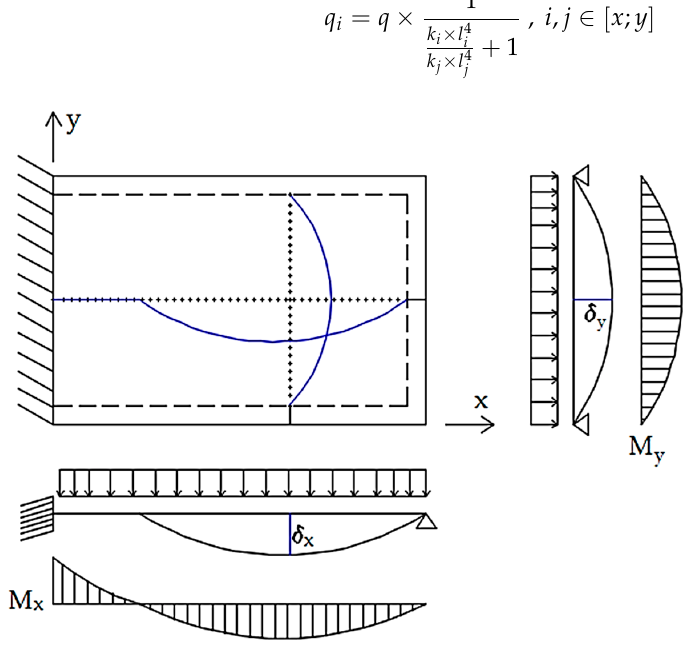
Figure 9. Displacement compatibility at one point for a slab with one fixed-ended border.